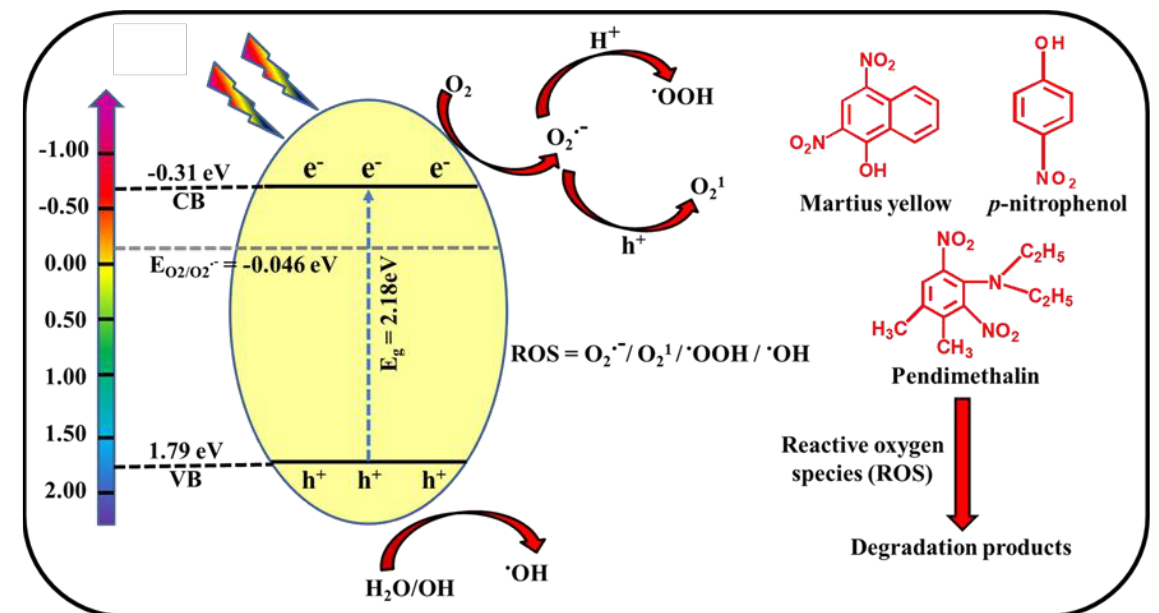
Figure 12. Plausible photodegradation mechanism for the photodegradation of nitroaromatic pol- lutants.